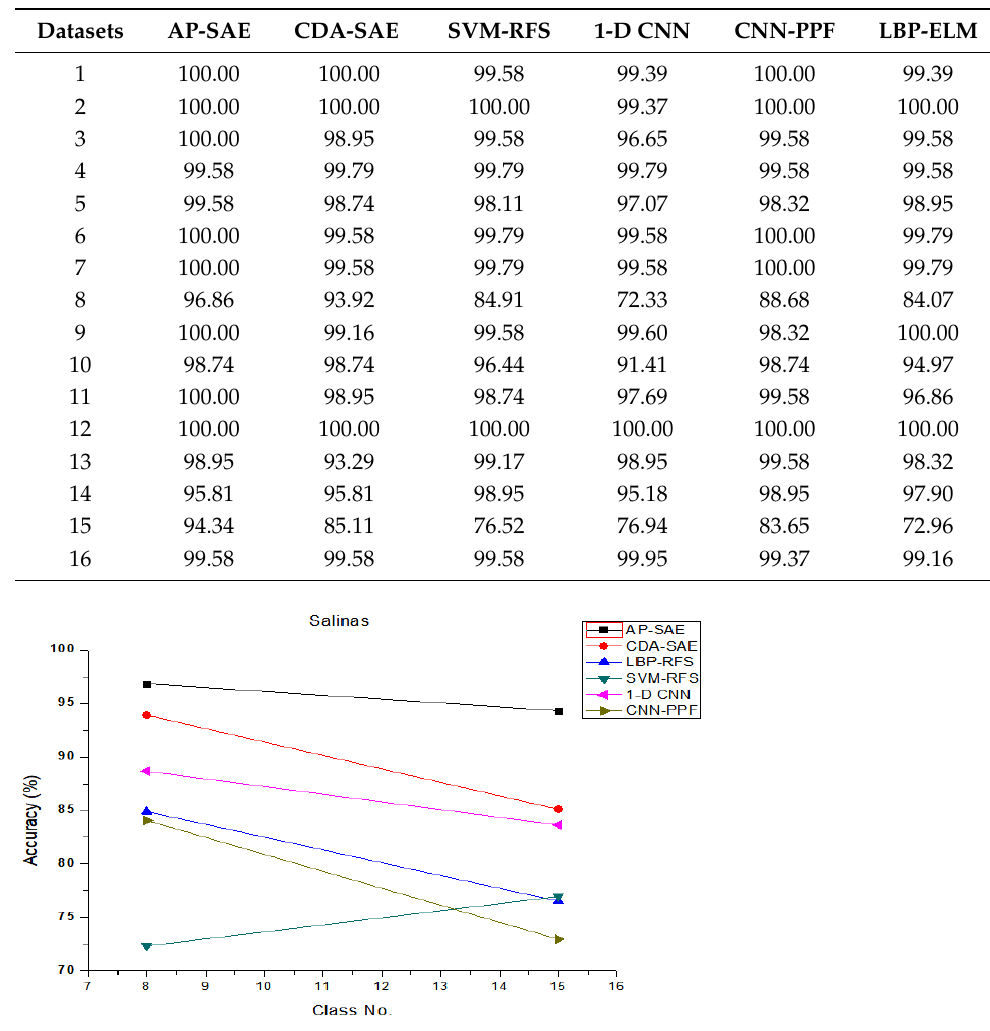
Table 10. Different methods of various types of accuracy comparison results for the Salinas dataset.